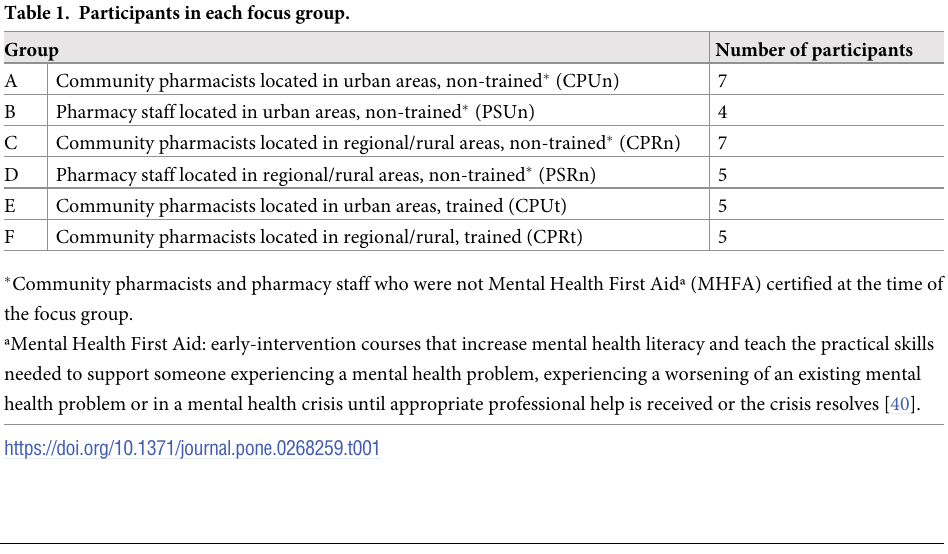
Participant demographics are provided in Table 2. The average duration of the first six focus groups was 89 minutes (SD 7.7).